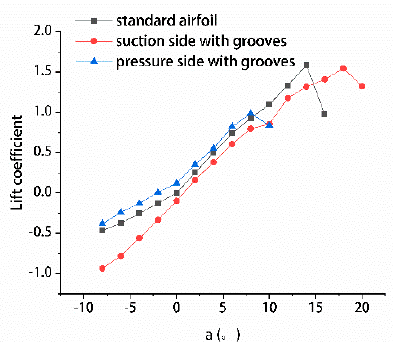
ffi cient with angle of attack. Figure 9. Variation of lift coefficient with angle of attack. Figure 9. Variation of lift coe